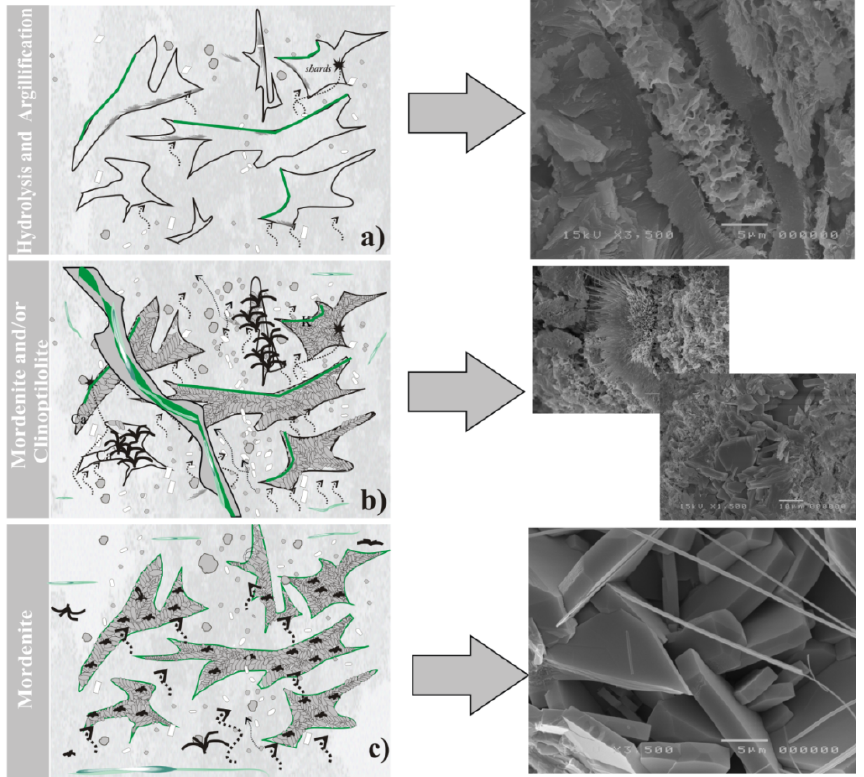
Figure 10. Proposed conceptual model of the zeolitization process (modified by [30]) and supporting textures in the rocks imaged by electron microscopy. Three steps are hypothesized: ( a ) hydration and hydrolysis of the volcanic glass with smectite formation; ( b ) transformation in mordenite and subordinate glauconite development; ( c ) clinoptilolite formation [52].